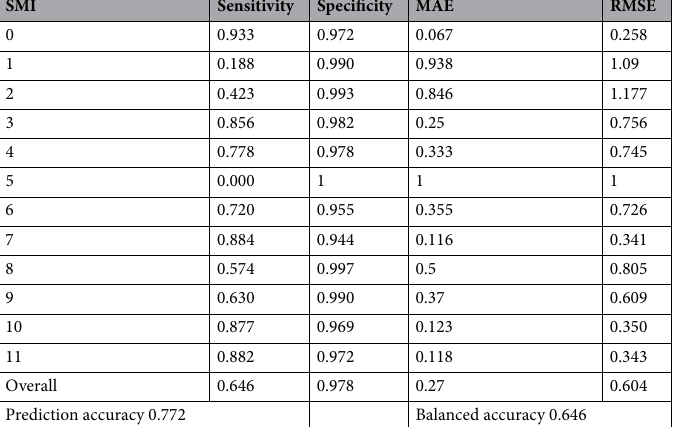
Table 1. Performance of automated SMI assessment system. SMI, skeletal maturity indicators; MAE, mean absolute error; RMSE, root mean square error.